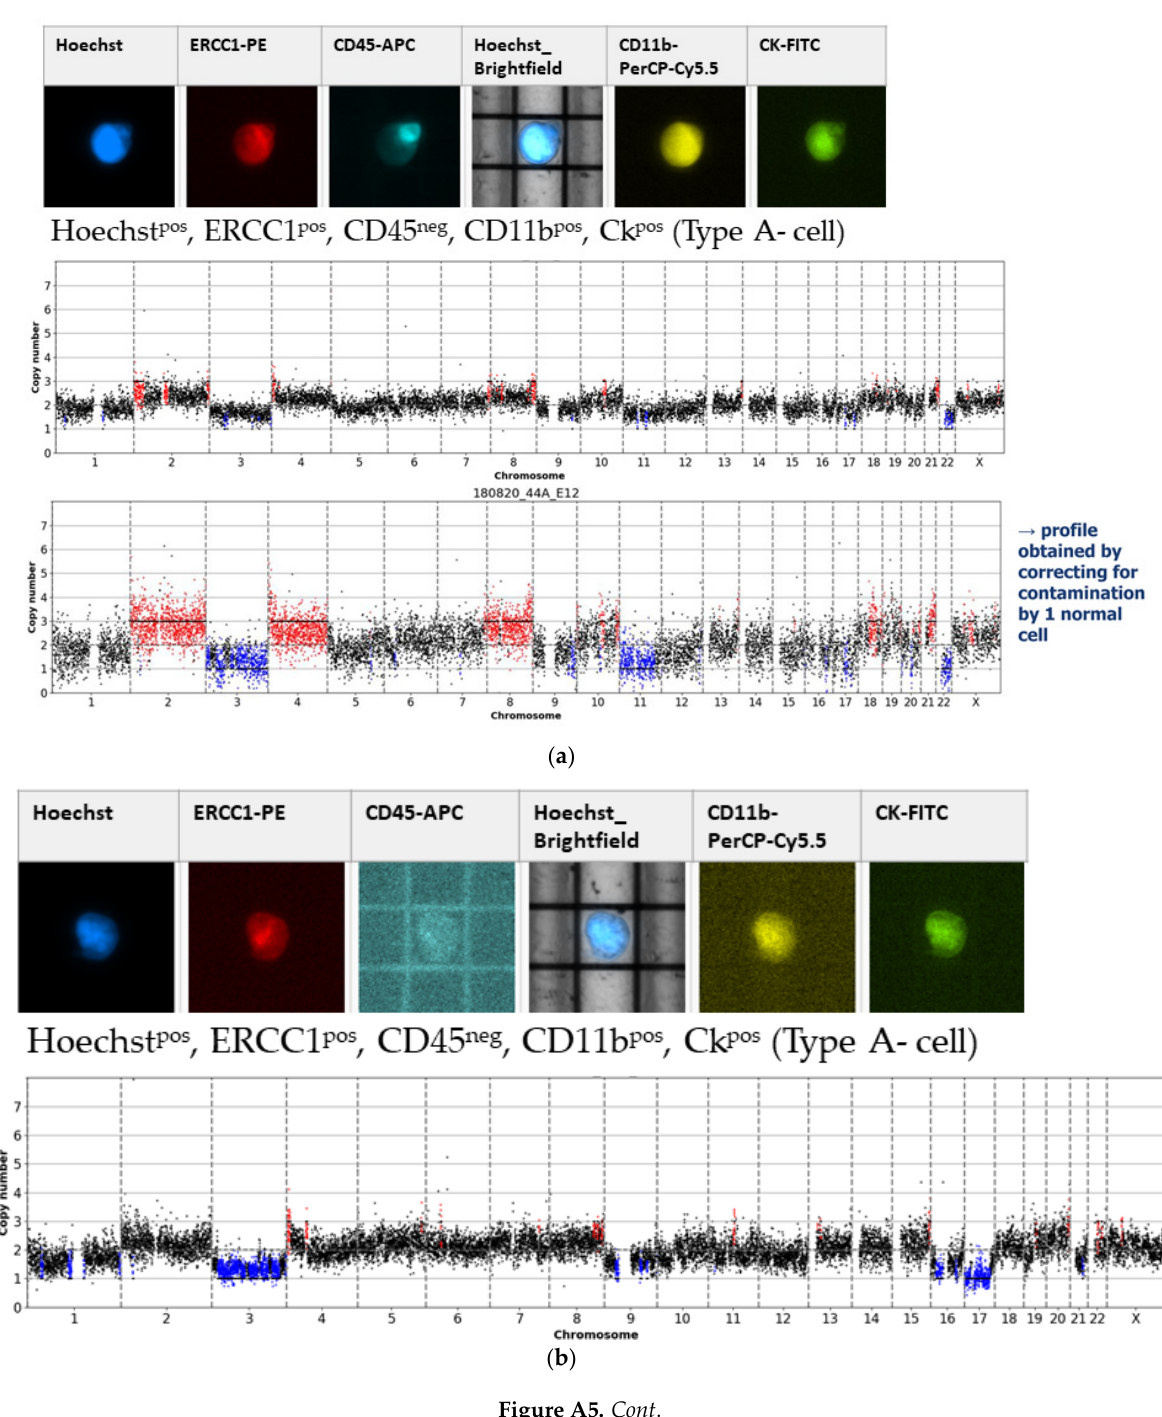
Figure A4. CN profiles of germline samples from all 13 patients . Cells (range 7-10) positive for CD45 and the nucleus counter staining Hoechst were isolated in every patient. For patient 10, the quality of the WGA product was not compatible with the further downstream analysis, therefore, one Hoechst pos and CD11b pos cell was used as a germline